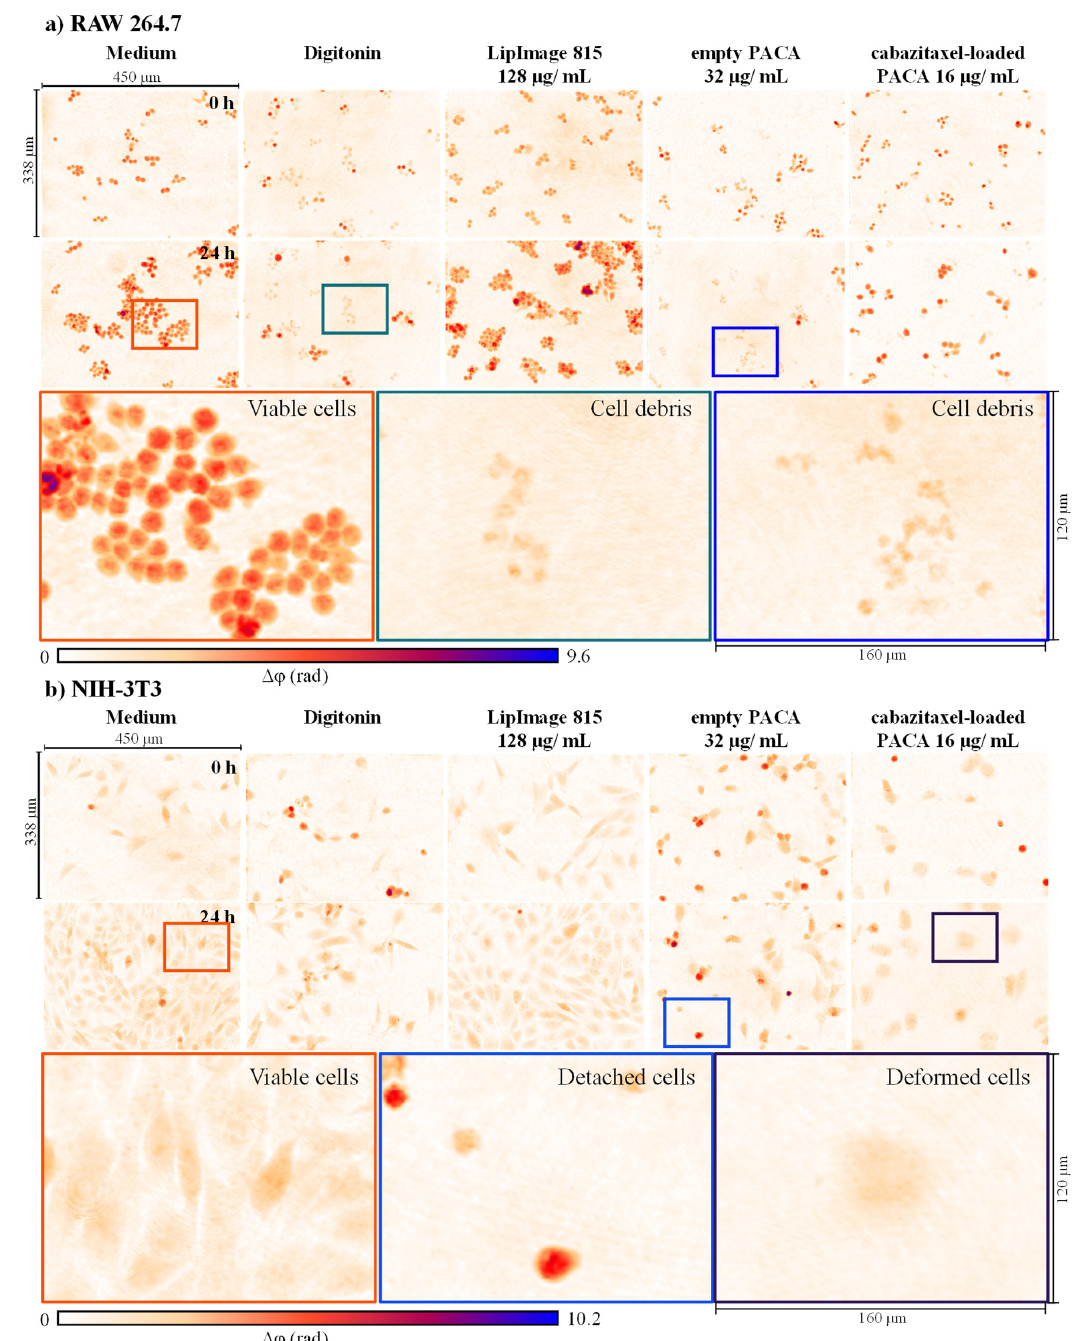
Figure 2. Representative false color-coded DHM QPI images of RAW 264.7 macrophages ( a ) and NIH-3T3 fibroblasts ( b ) incubated with controls and nanoparticles at time points t = 0 h and t = 24 h. For both cell lines, cell culture medium control and cytotoxicity control digitonin is shown. In digitonin controls, cell proliferation was inhibited from time point t = 0 h to t = 24 h. Orange boxes show enlarged areas with viable cells in cell culture medium control. Enlarged areas in green boxes indicate cell debris of lysed RAW 264.7 macrophages. Cells incubated with 128 µg/mL of LipImage™ 815 lipidots® nanoparticles proliferated and grew to a similar extent as observed in the cell culture medium control. For cells incubated with 32 µg/mL of empty PACA nanoparticles, cell proliferation was inhibited. Detached cells are shown in the blue framed enlarged image areas. Incubation with 16 µg/mL of cabazitaxel-loaded PACA nanoparticles caused cell deformation, indicated in the enlarged purple framed area, and similar to PACA nanoparticles, proliferation was inhibited.